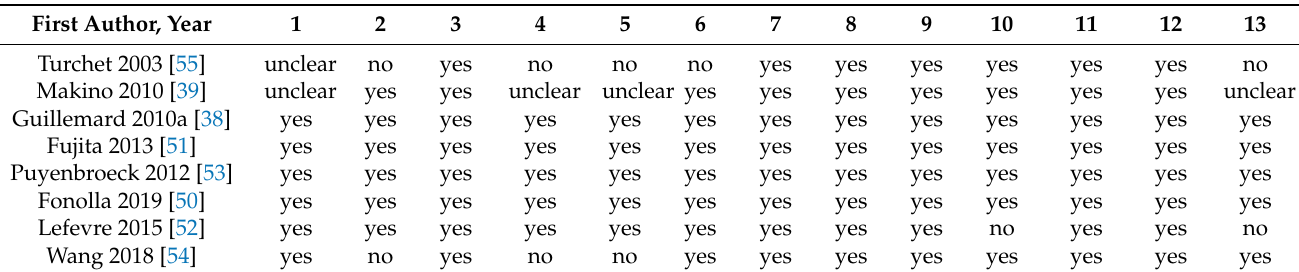
Table 2. Quality assessment checklist of included clinical trials using the Joanna Briggs Institute critical appraisal tool for randomized controlled